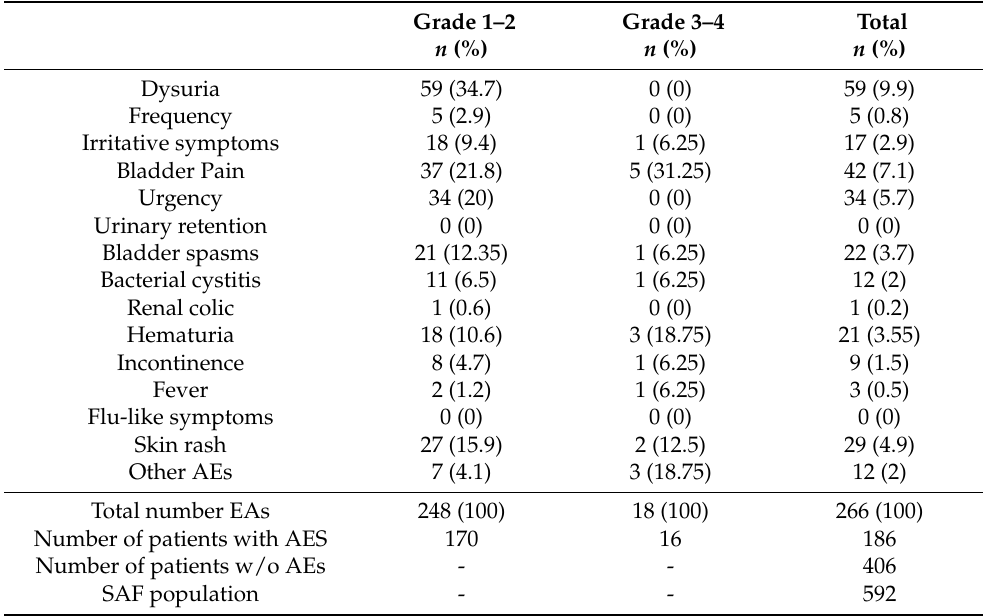
Table 6. Frequency and severity of adverse events (AEs) for FAS population ( n = 592) receiving at least one instillation of HIVEC